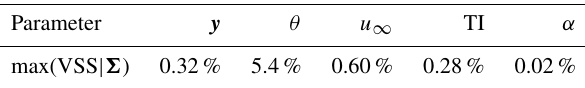
Table 4. Maximum VSS across all speeds and directions consid- ered, given the reference standard deviation values in Table